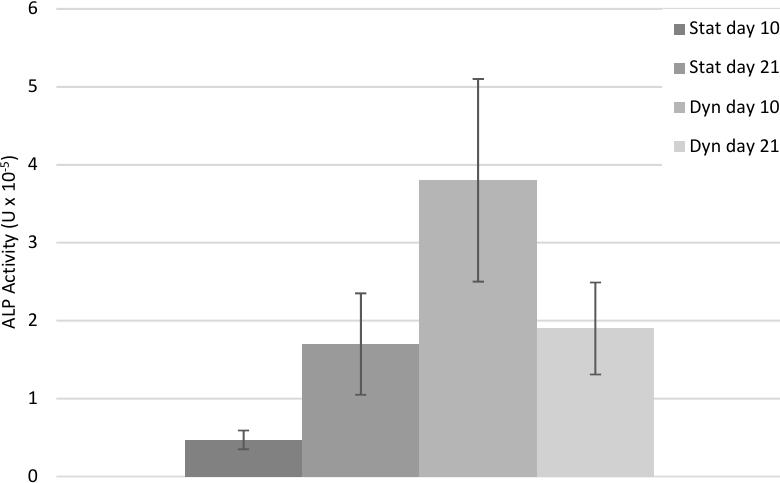
Figure 6. ALP activity (U) averaged over the three series for the static and dynamic groups at days 10 and 21.